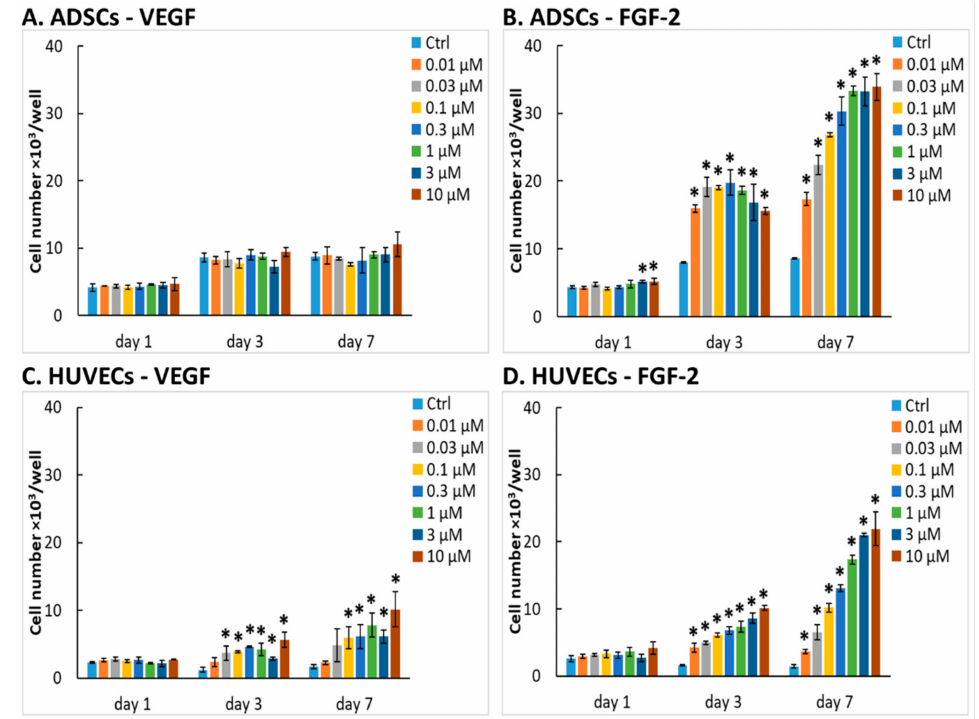
Figure 4. The mitogenic activity of VEGF-A 165 or FGF-2M adsorbed on the cultivation substrate. The ADSCs ( A , B ) or HUVECs ( C , D ) were seeded in wells of 96-well polystyrene tissue culture plates pre-adsorbed with VEGF-A 165 ( A , C ) or FGF-2M ( B , D ) in concentrations from 0.01 to 10 µ M. Pristine wells without growth factors served as control substrates (Ctrl). ADSCs were grown in DMEM with 10% FBS. HUVECs were grown in EGM2-weak. The cell number was determined on days 1, 3, and 7 after seeding. Mean ± SD from 3 wells. Holm–Sidak method, p ≤ 0.05. The samples were statistically compared on the indicated day after seeding. * statistically significant difference in comparison with the control sample